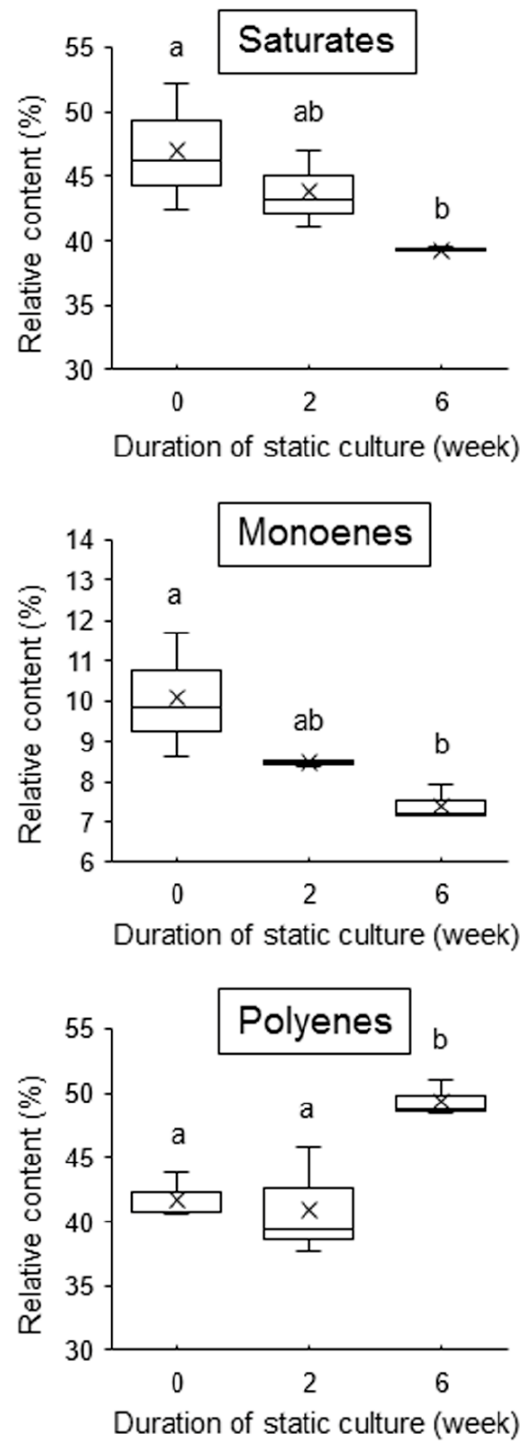
Figure 2. Effects of static culture on membrane fatty acid compositions in ‘ Bangia ’ sp. ESS1. Changes in the relative amounts of saturated fatty acids (Saturates), monounsaturated fatty acids (Monoenes), and polyunsaturated fatty acids (Polyenes) were analyzed in thalli statically cultured for 2 and 6 weeks in comparison with control samples (0) without static culture. Letters on boxes denote significant differences from triplicate experiments defined by the Tukey–Kramer test ( p < 0.05) in one-way ANOVA.